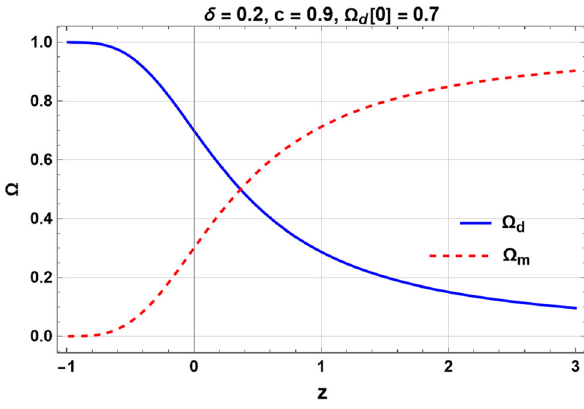
Fig. 7 The NTHDE density parameter (cid:6) d and dark matter density parameter (cid:6) m is depicted. The graph is plotted against the redshift z by considering δ = 0 . 2 , c = 0 . 9 , (cid:6) d [ z = 0 ] ≈ 0 . 7 , M 2 p = 1. Where the present time corresponds to z =